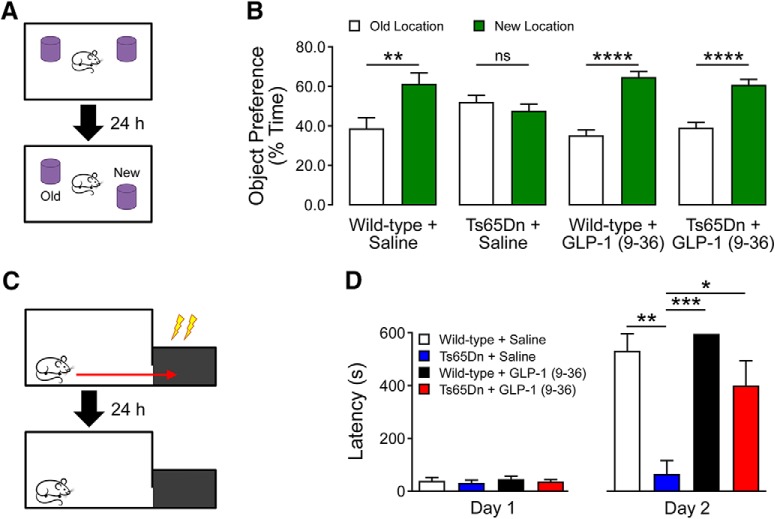
GLP-1 (9-36) treatment alleviates cognitive deficits in Ts65Dn mice. A, Schematic of OLM task and object preference for familiar and new locations during the test session. B, Spatial memory was impaired in Ts65Dn mice compared with WT controls, and the impairments were rescued with GLP-1 (9-36) treatment. Preference for the new location <50% of the total interaction time indicates cognitive impairment (WT+ Saline: n = 10; Ts65Dn + Saline: n = 11; WT+ GLP-1 (9-36): n = 12; Ts65Dn + GLP-1 (9-36): n = 13; **p < 0.01, ***p < 0.001, independent t test). C, Schematic of passive avoidance paradigm and latency to dark compartment on Day 1 and Day 2 of the test. D, No differences were observed in latency to dark compartment on acquisition day (Day 1; one-way ANOVA; p > 0.05). On test day (Day 2), Ts65Dn mice had a significantly shorter latency to enter into the dark compartment than WT control groups, indicating cognitive impairments. In contrast, GLP-1 (9-36) treatment significantly increased latency to the dark compartment in Ts65Dn mice, indicating improved cognitive function. None of the WT mice treated with GLP-1 (9-36) entered the dark compartment on testing day. (WT+ Saline: n = 7; Ts65Dn + Saline: n = 3; WT+ GLP-1 (9-36): n = 9; and Ts65Dn + GLP-1 (9-36): n = 7). One-way repeated-measures ANOVA with Tukey’s post hoc tests; *p < 0.05, **p < 0.01, ***p < 0.001, ****p < 0.0001.